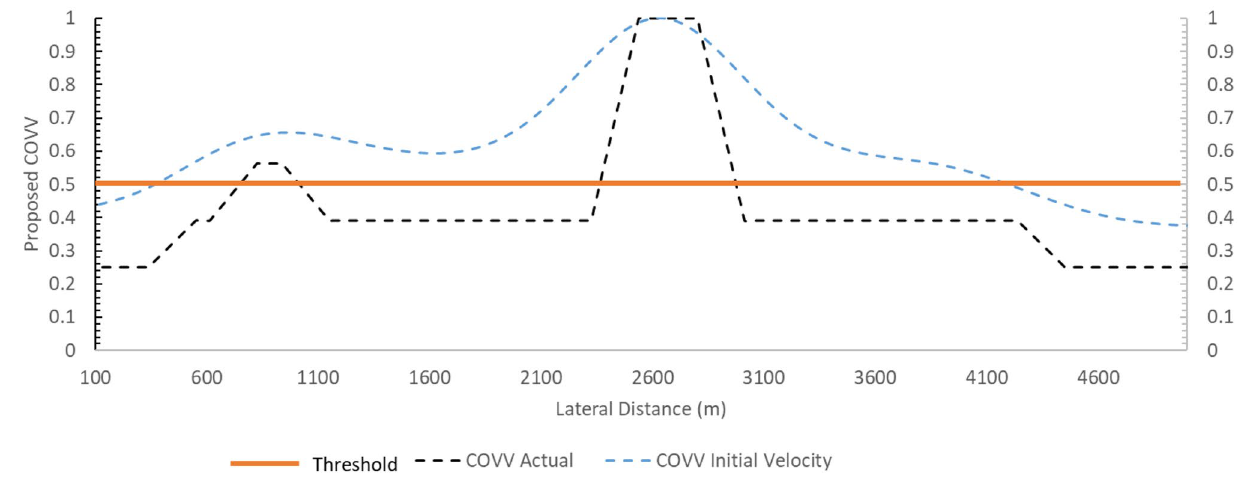
Fig. 12 Proposed Co-efficient of Velocity Variation for initial and Actual velocity profile in the lateral direction. For initial iterations, most of the model is updated by cosine-based weights which helps